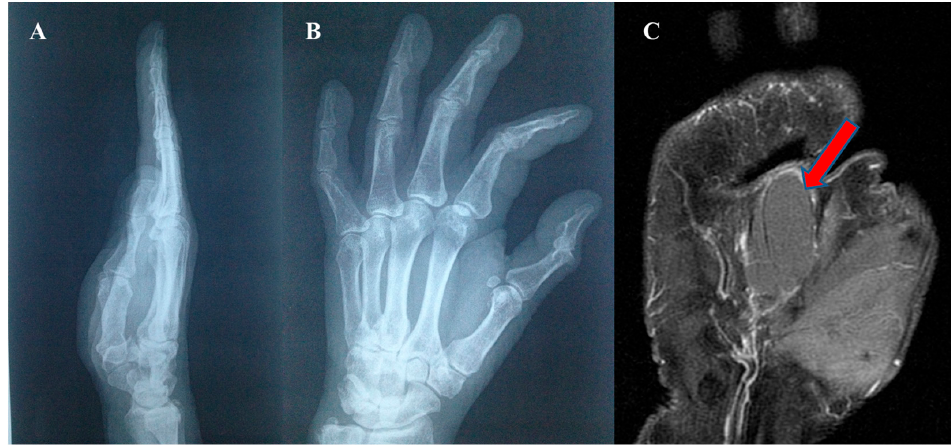
Figure 10. Epidermal inclusion cyst of the palm. ( A , B ) radiological aspect, ( C ) MRI aspect . Surgery was performed under loco-regional anesthesia (axillary block). A wide surgical excision area was created through incisions parallel to palmar flexion creases (to avoid retractile scars), thus allowing the wide dissection and complete removal of the cysts (Figure 11).